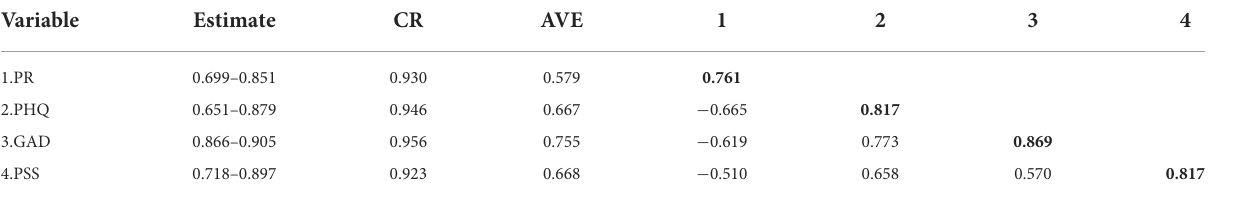
TABLE 3 Results of confirmatory factor analysis of each measure. Variable